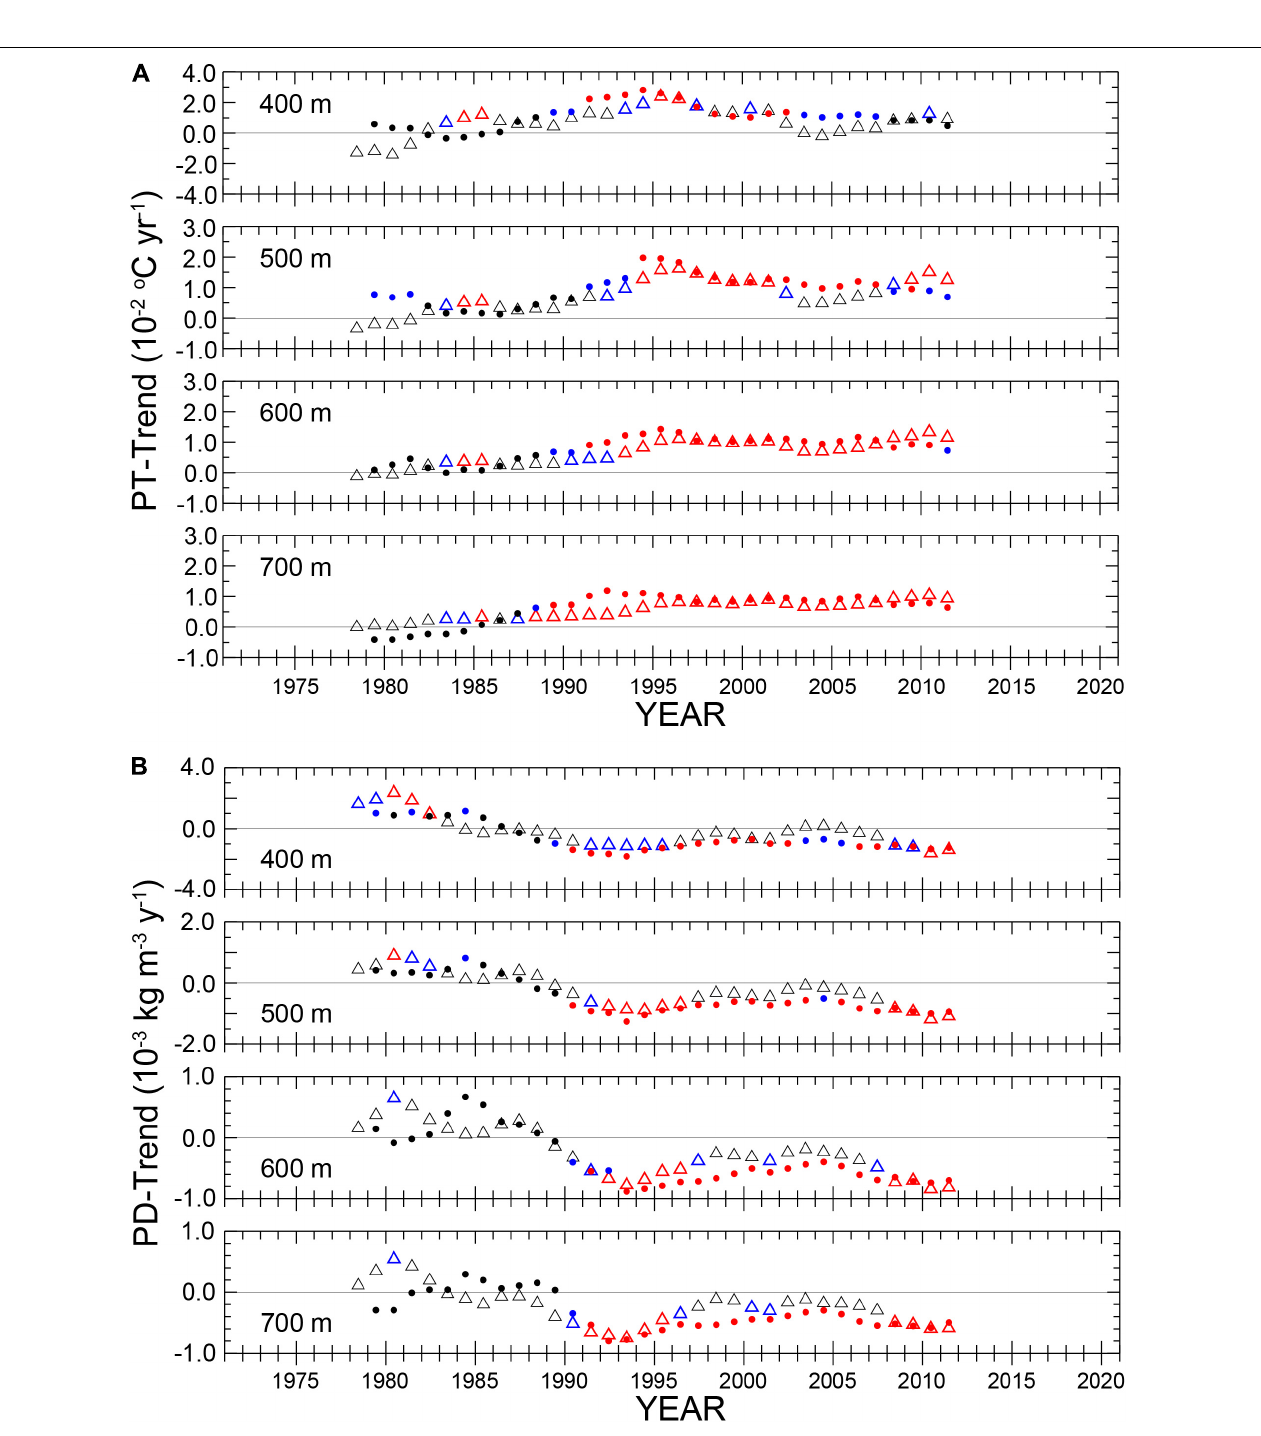
FIGURE 8 | Time series of the changing rates in PT (A) and PD (B) evaluated by a 15-year sliding window at 400, 500, 600, and 700 m at Stas. H-4 (solid circles) and PM5 (triangles). Statistically significant values at the 95 and 99% confidence levels are indicated by blue and red colors, respectively.